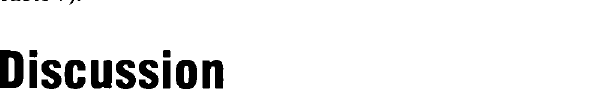
Treatment modalities